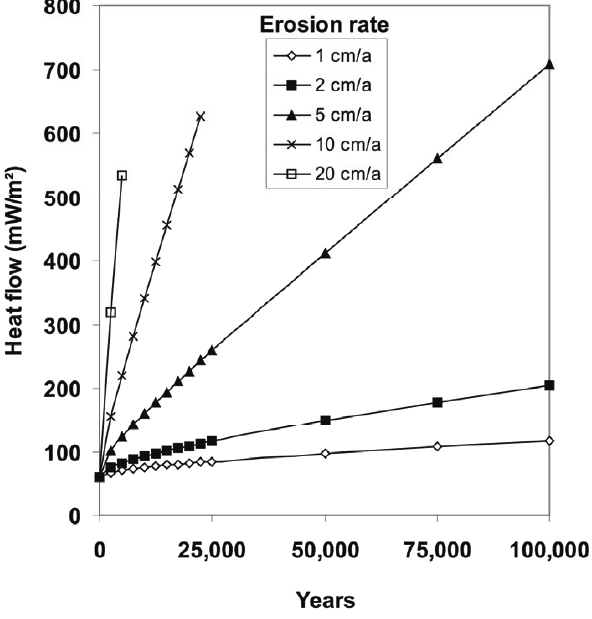
Fig. 7. Increase of heat flow as function of erosion rate and time. Fig. 7 Steady erosion lifts deeper-seated and warmer sediments closer to the sea floor, with the consequence of artificially enhanced heat flow. The shown relation is based on an analytical solution of this situation, initially presented by Benfield